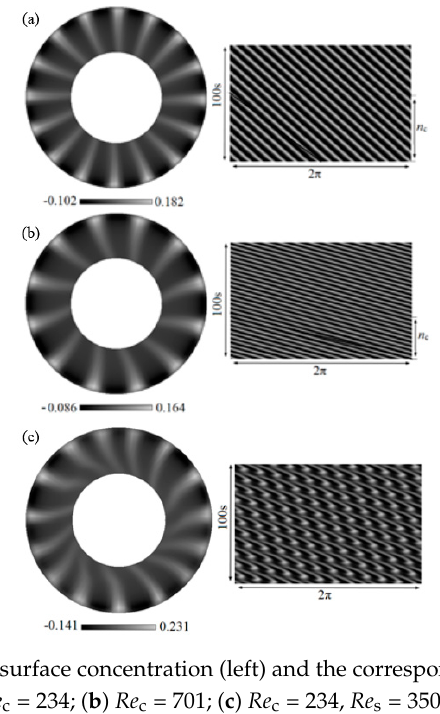
Figure 14. Snapshots of the surface concentration (left) and the corresponding STD at R = 0.55 (right) when Re T = 6.0 × 10 3 . ( a ) Re c = 234; ( b ) Re c = 701; ( c ) Re c = 234, Re s = 3506.